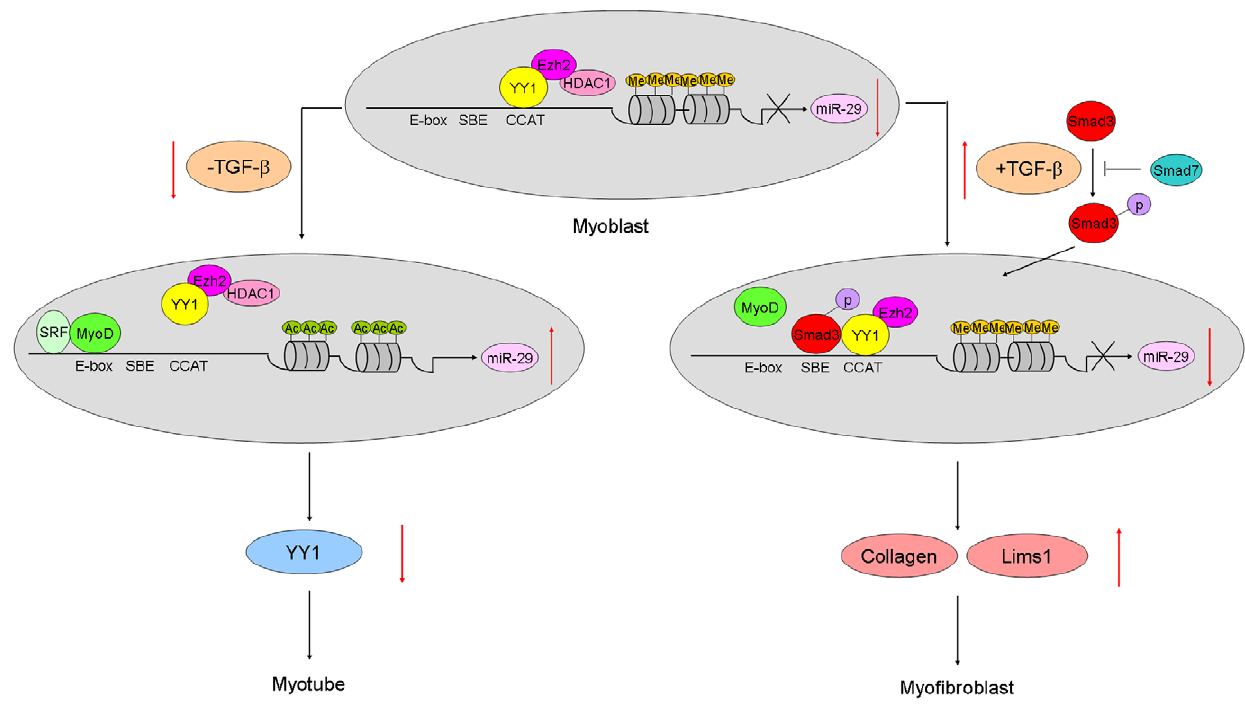
Figure 6. A model of TGF- b -Smad3-miR-29 circuit in myogenic and fibrogenic differentiation of C2C12 myoblasts. The model depicts the roles of the TGF- b -Smad3-miR-29 regulatory circuit in myogenic and fibrogenic differentiation of C2C12 cells. In the normal myogenesis, the recruitment of MyoD/SRF and the displacement of YY1/PRC from miR-29 promoter lead to the elevation of miR-29 expression and its feedback inhibition on YY1 and successful myogenic differentiation. Upon TGF- b stimulation, activated Smad3 translocates into nucleus where it binds to SBE, resulting in MyoD dissociation as well as YY1/Ezh2 recruitment to multiple CCAT boxes of miR-29b/c promoter. This leads to trimethylation of histone lysine 27 and subsequent silencing of miR-29 expression. Loss of miR-29 upregulates the expression of ECM genes such as Collagens as well as cell adhesion genes such as Lims1, thus promoting the conversion of myoblasts into myofibroblasts. Straight line, promoter/enhancer region of mmu- miR-29b/c with arrow denotes TSS; CCAT, YY1 binding elements; E-box, MyoD binding sites; SBE, Smad3 binding element; Me, methylation of histone lysine 27; Ac, acetylation of histones.